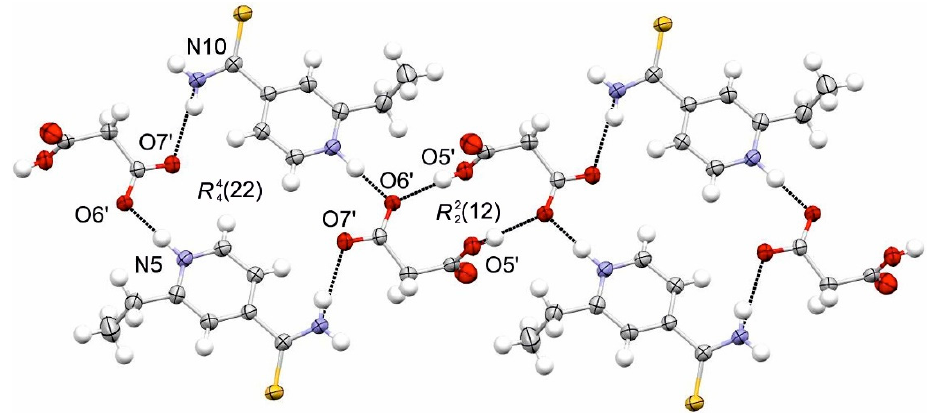
Figure 4. HB pattern of ETN·MAL, highlighting the centrosymmetric 𝑅 (cid:2870)(cid:2870) (12) dimer and the 𝑅 (cid:2872)(cid:2872) (22) cyclic motif.